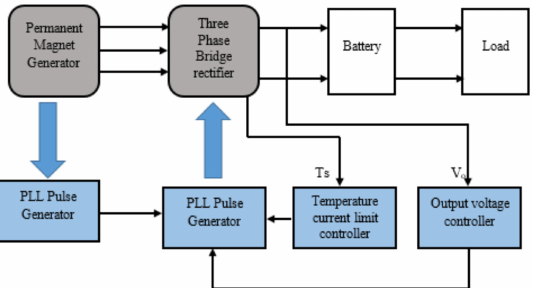
Figure 35. Variable frequency SCR controller block diagram “Reprinted from [37]”.